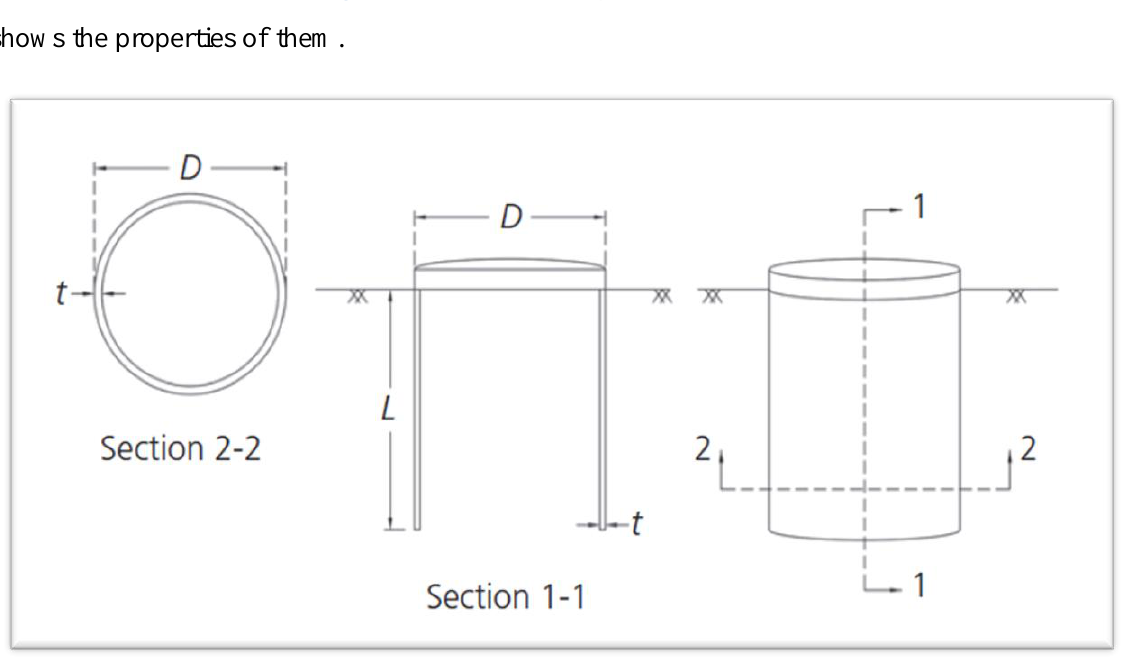
Fig. 2. Schematic view of the circular, skirted foundation.